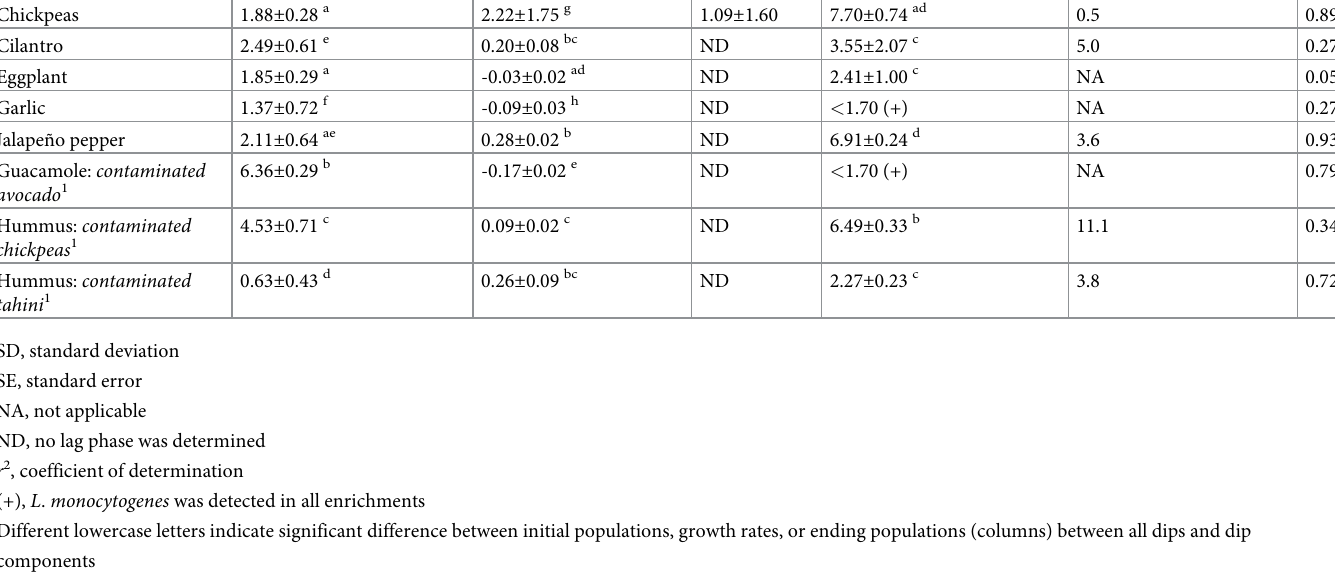
Different lowercase letters indicate significant difference between initial populations, growth rates, or ending populations (columns) between all dips and dip components 1 Component inoculated at 2 log CFU/g L . monocytogenes and then stored at 10˚C for 7 d prior to dip